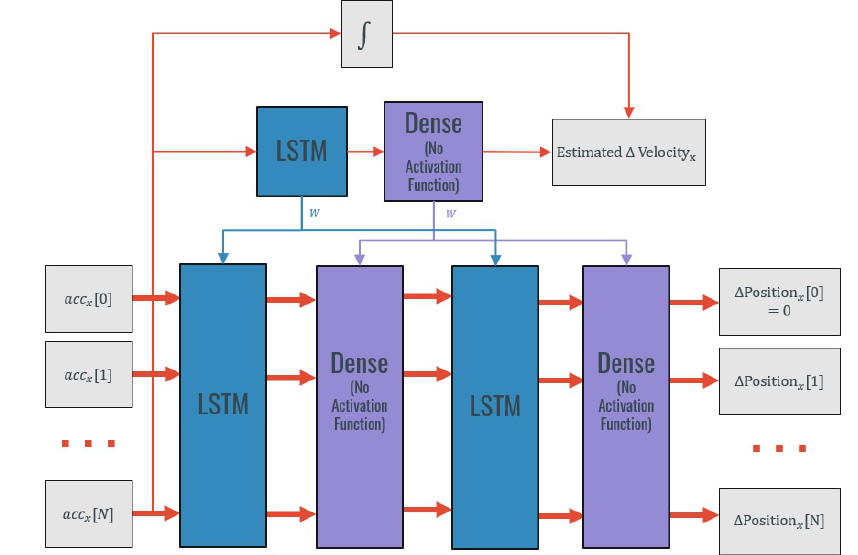
Figure 5. Representation of the warm-Start with “pre-trained” weights methodology—example for the